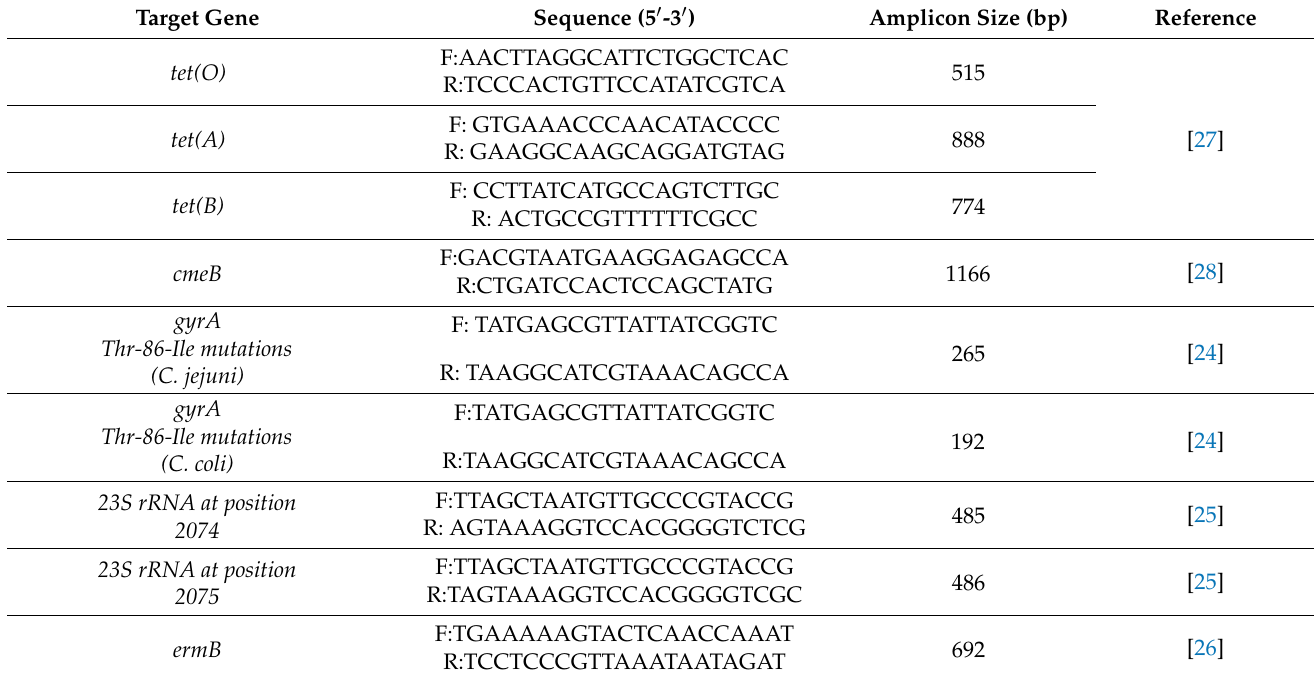
Table 1. Primer sequences used for species identification and detection of resistance genes and mutations. Target